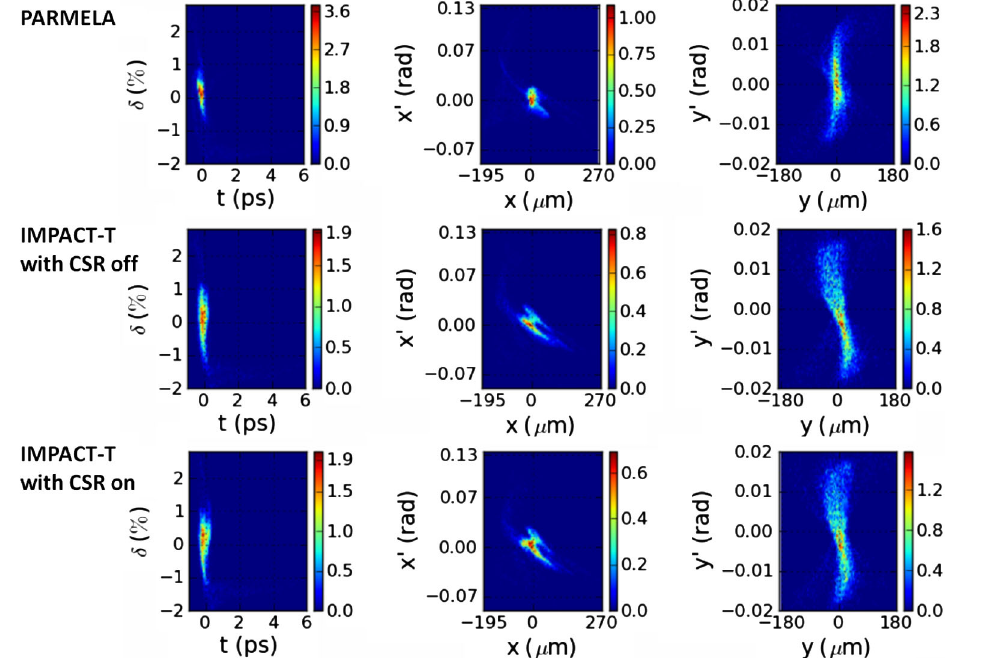
FIG. 9. The histograms of the bunch ’ s longitudinal phase space (the left column), horizontal phase space (the middle column), and vertical phase space (the right column) at the end of the compressor. These plots are plotted for 100% particles at the final point of the linac bunch compressor. Data come from different simulation codes for the same linac compressor of case 3 in Table II: PARMELA (the first row), IMPACT - T with CSR effects turned off (the second row), and IMPACT - T with CSR effects turned on (the third row). The color bar shows the particle